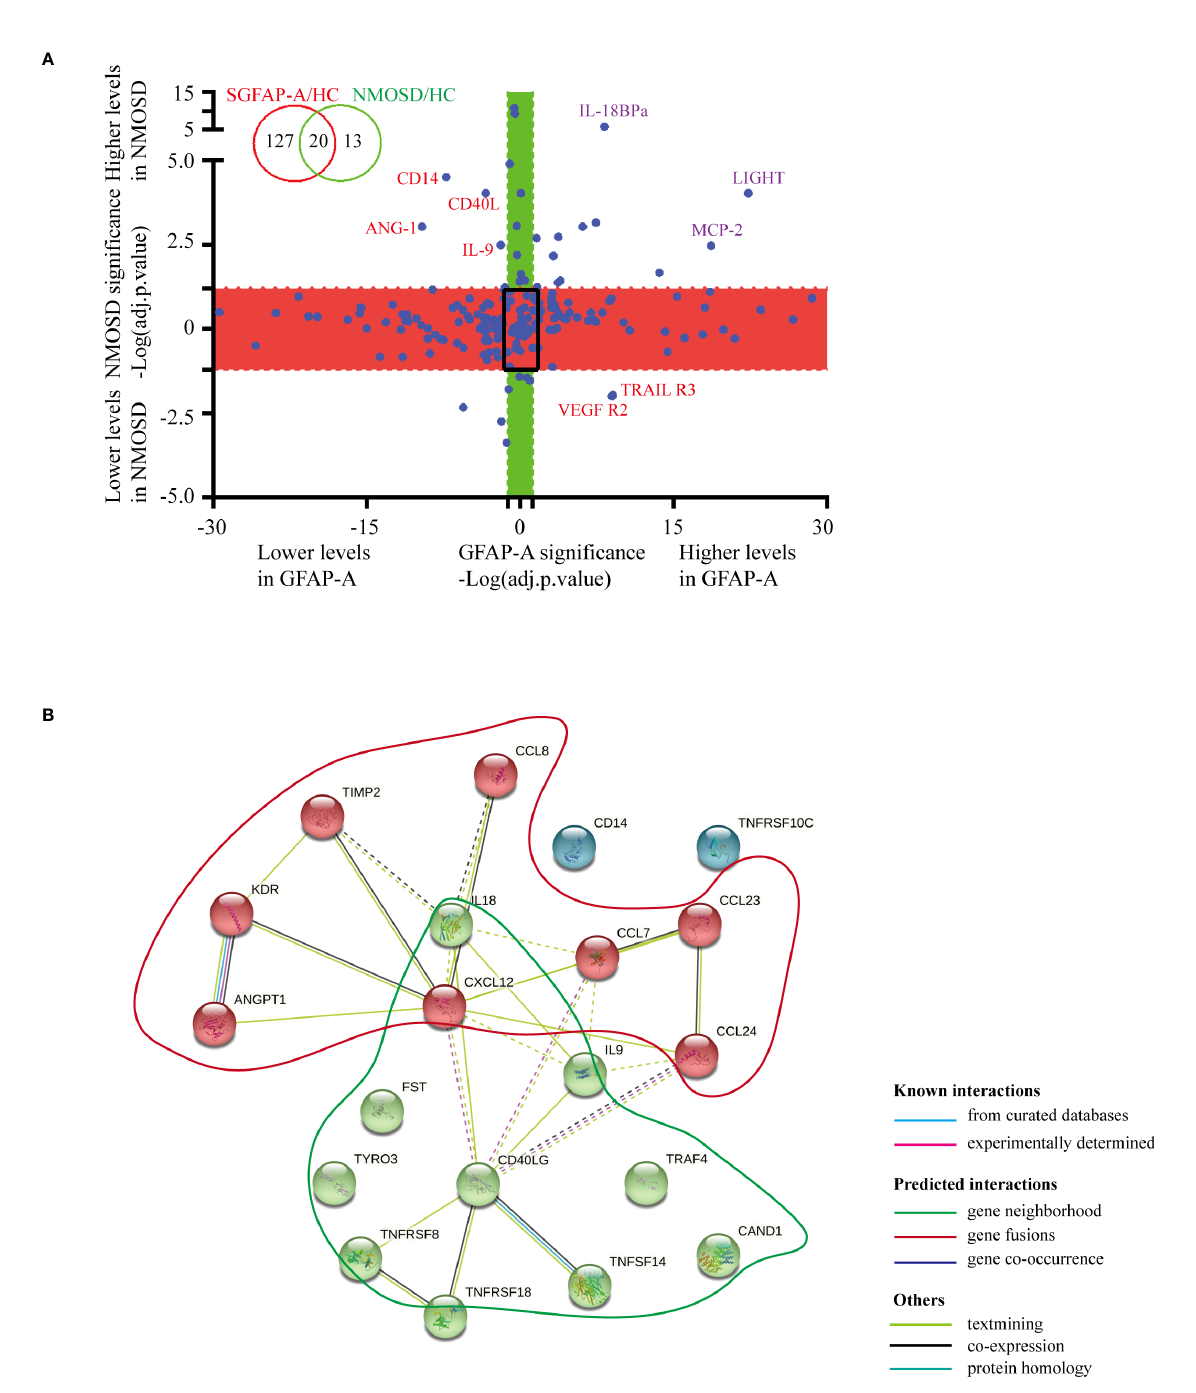
FIGURE 2 Serological protein pro fi les of GFAP and NMOSD patients reveal disease-common and disease-speci fi c information. (A) Plot of the log10- transformed adjusted p value (adj.P.val) of GFAP-A and NMOSD data show preserved directionality, which resulted in the classi fi cation offour distinct groups: “ Both changed ” (adj.P.val GFAP-A < 0.05 and adj.P.val NMOSD < 0.05, same direction of changes in both diseases); “ Changed in GFAP-A compared to NMOSD ” (adj.P.val GFAP-A < 0.05, adj.P.val NMOSD >0.05, red box); “ Changed in NMOSD compared to GFAP-A ” (adj.P.val NMOSD < 0.05, adj.P.val GFAP-A > 0.05, green box); “ Non-signi fi cant ” (adj.P.val GFAP-A and adj.P.val NMOSD > 0.05, black frame). (B) STRING analysis of 20 DEPs in the GFAP-A and NMOSD patient groups compared to HCs. A total of three clusters were identi fi ed with known/predicted/other interactions. Cluster 1, represented with 9 red balls, and was centered in CD40LG. Cluster 2, represented with 8 green balls, was centered on